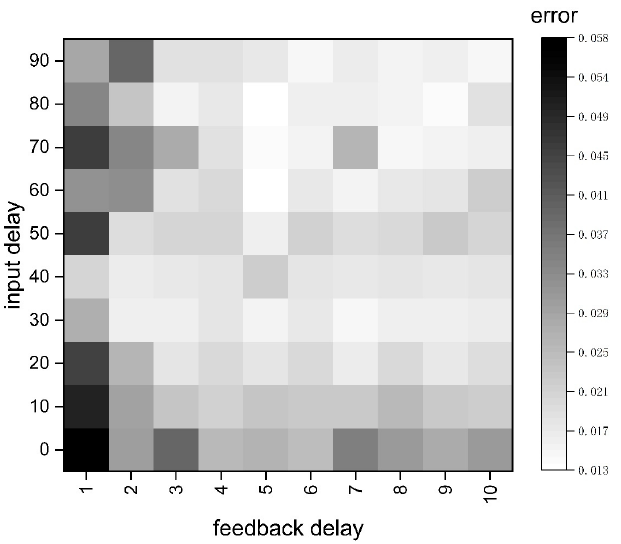
Figure 8. Average error result.